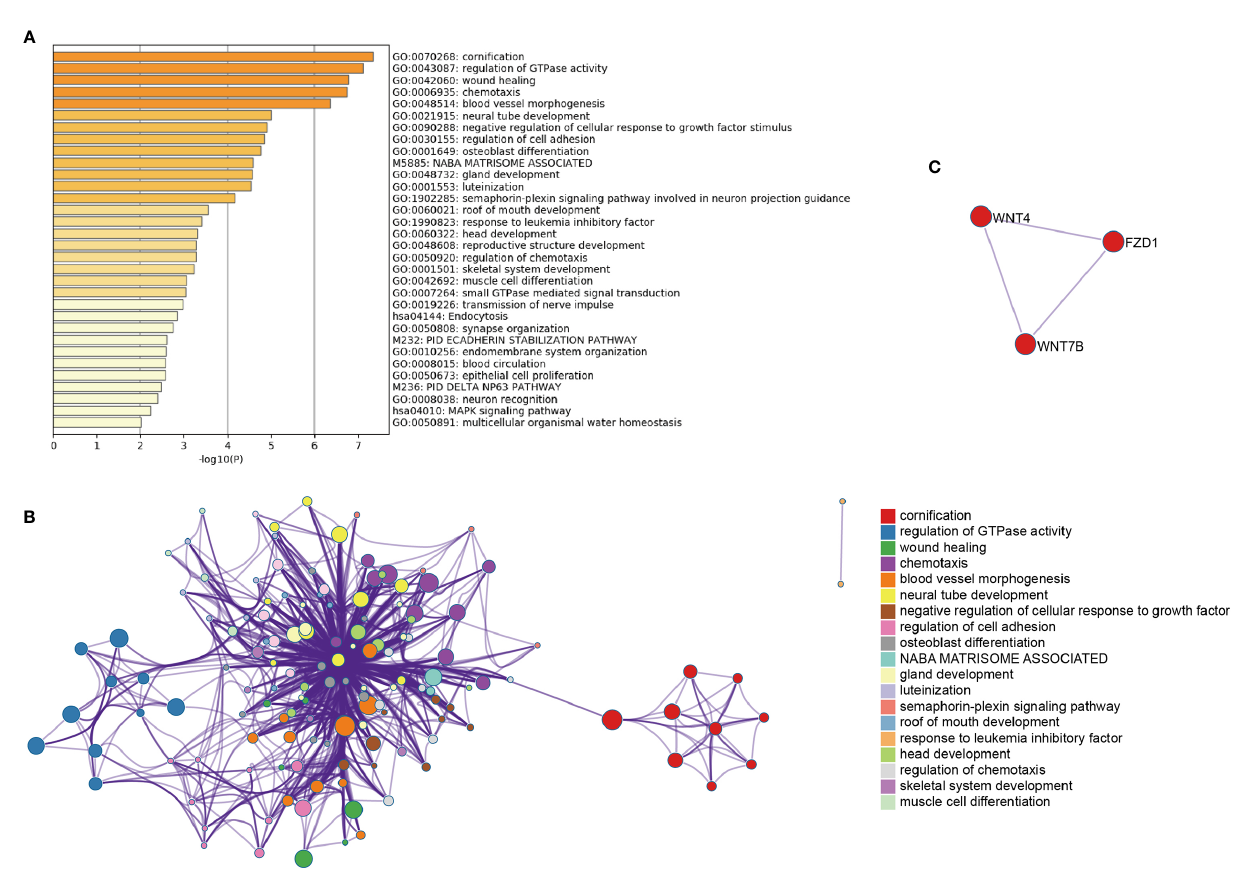
FIGURE 4 | Gene enrichment analysis of the AC006262.3-signature. (A) The histogram of the top 19 enriched pathways associated with risk score in AC006262.3 was arranged by -Log10P value. Each bar represented one enriched term and was coloured by -Log10P value; (B) Using Metascape to cluster the pathways related with AC006262.3. The top 19 enriched pathways were shown (right panel); (C) The pathways related with AC006262.3 were clustered by MCODE ZNF